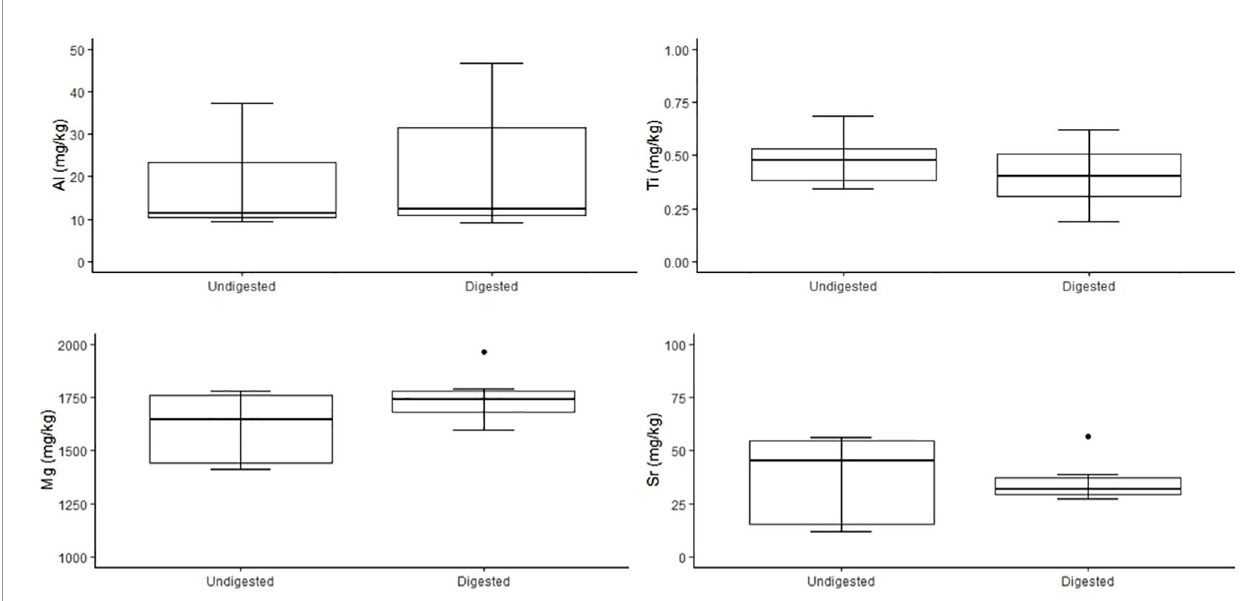
FIGURE 4 | Comparison of concentrations of trace elements Al, Ti, Mg and Sr (mg/kg dry weight) of undigested ( n = 7) and digested ( n = 7) feathers from carcass of n = 1 little penguin. Box plots display median values with box edges representing lower (Q1) and upper (Q3) quartiles, de fi ned as the 25th and 75th percentiles, whiskers representing variability outside the upper and lower quartiles and dots representing outliers.